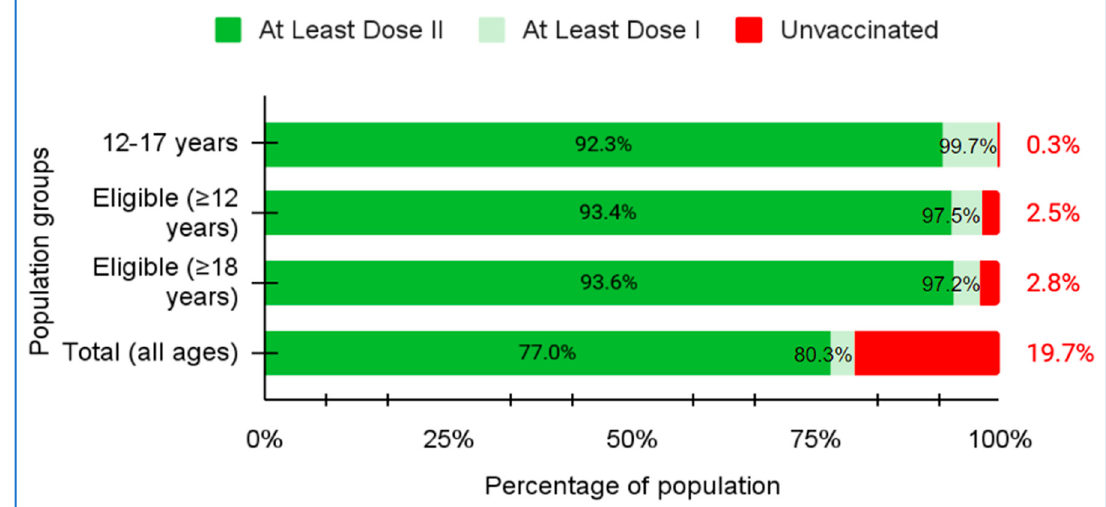
Figure 3. C OVID ‐ 19 vaccination coverage for the first and second doses. Figure 3. COVID-19 vaccination coverage for the first and second doses.